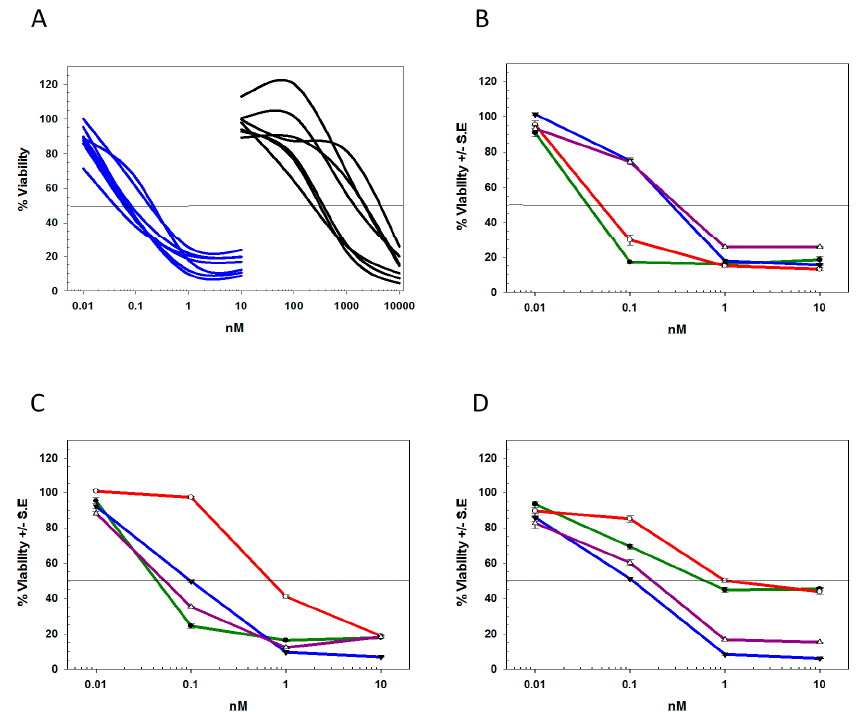
Figure 2. ( A ) Cytotoxicity of deB-C6.5-diab (blue) and deB (black) against a panel of HER2 3+ cell lines. Cytotoxicity of deB-C6.5-diab (blue), T-DM1 (red), T-MMAE (green); and T-deB (purple) against SK-BR-3 ( B ); BT-474 ( C ); and HCC1419 ( D ) cells. Table 1. Potency of deB-C6.5-diab, T-deB, T-DM1, and T-MMAE against carcinoma cell lines.